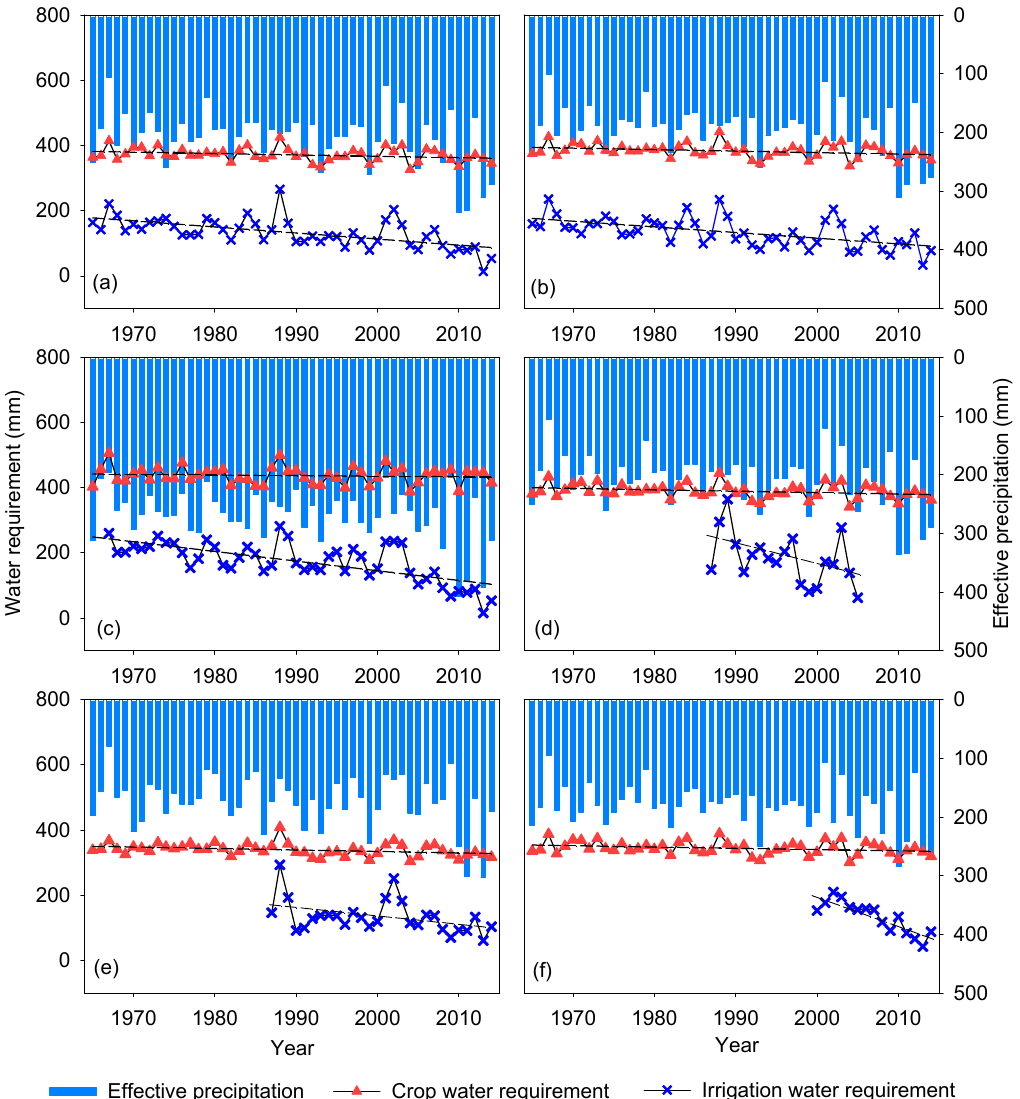
Figure 2. Temporal variations of effective precipitation, crop water requirement, and irrigation requirement for six crops in Saskatchewan from 1965 to 2014. ( a ) spring wheat; ( b ) barley; ( c ) canola; ( d ) sunflower; ( e ) lentil; ( f ) chickpea.